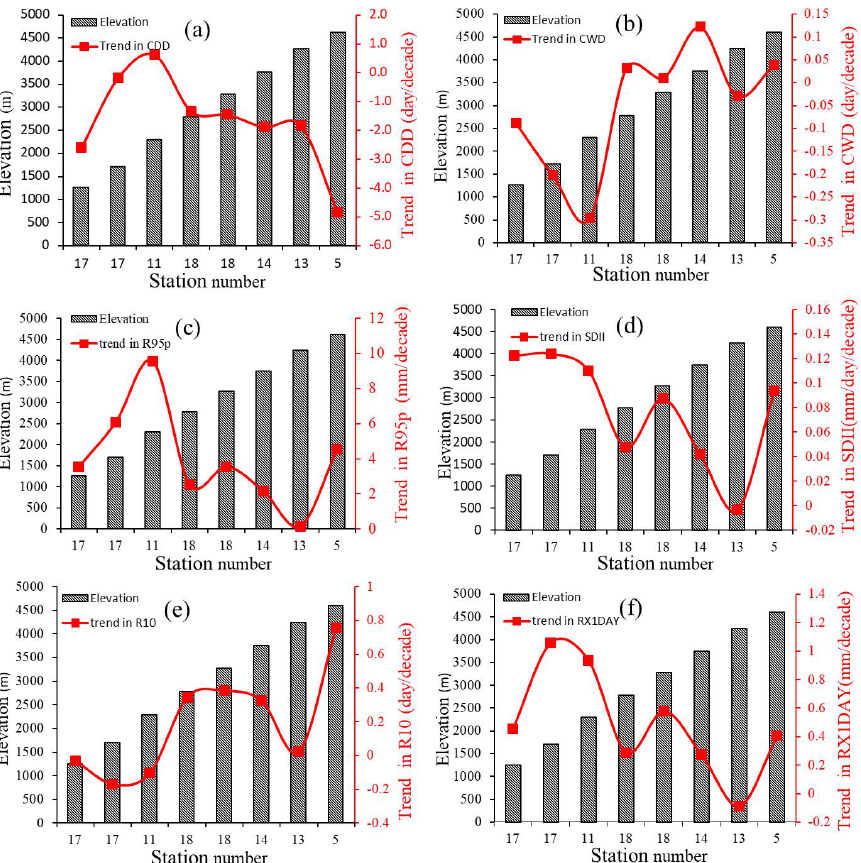
Figure 10. Elevation dependence of extreme precipitation trends (mm/decade) (( a ) CDD; ( b ) CWD; ( c ) R95p; ( d ) SDII; ( e ) R10; ( f ) RX1day) in the TP and TPS during 1971–2017, (The numbers in horizontal axis represent the stations in each 500 m elevation band, and trend magnitude is plotted on the y axis, the trends are the means over individual elevation bins).